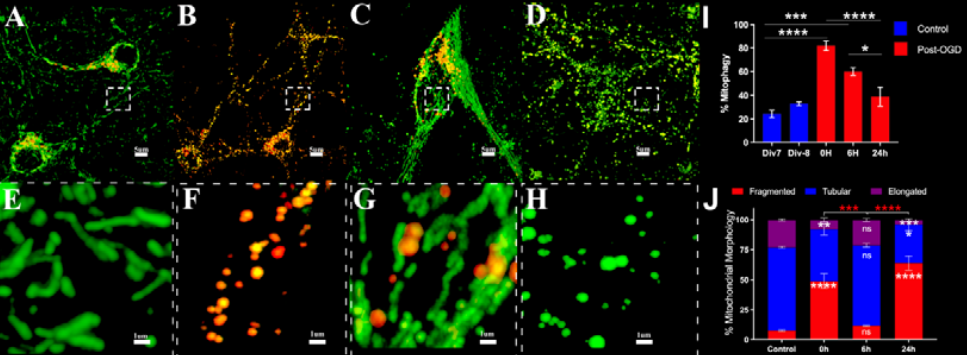
Figure 1. Changes in mitophagy and mitochondrial morphology in neurons following OGD by live cell airyscan imaging. ( A )—Control, ( B )—0 h post OGD, ( C )—6 h post OGD, ( D )—24 h post OGD, ( E ) to ( H )—high power overlay. ( I )—The graph represents changes in mitophagy over time. ( I )—Div7 and Div 8 represent controls for 0, 6 h and 24 h post OGD. The data are for at least 14 cells per condition in three independent experiments. ( J )—The graph shows the percentages of neurons with different forms of mitochondrial morphology in normoxic and OGD conditions * (inside stacked bars)—representing significant difference with respect to controls, * (outside stacked bars)—representing significant difference between time points * p ≤ 0.05, ** p ≤ 0.01; *** p ≤ 0.001; **** p ≤ 0.0001. Statistics compared by Kruskal–Wallis followed by Dunn’s multiple comparisons. The data are for at least 14 cells per condition in three independent experiments.